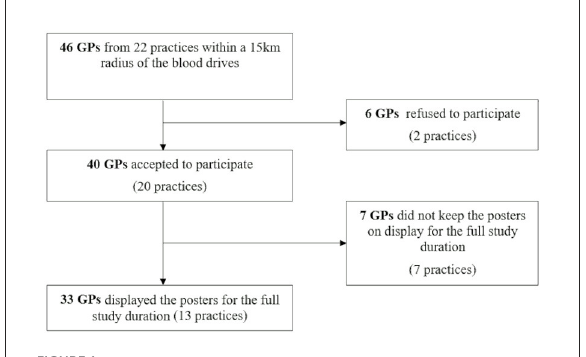
FIGURE1 Flowchart of the selection of participating general practitioners.